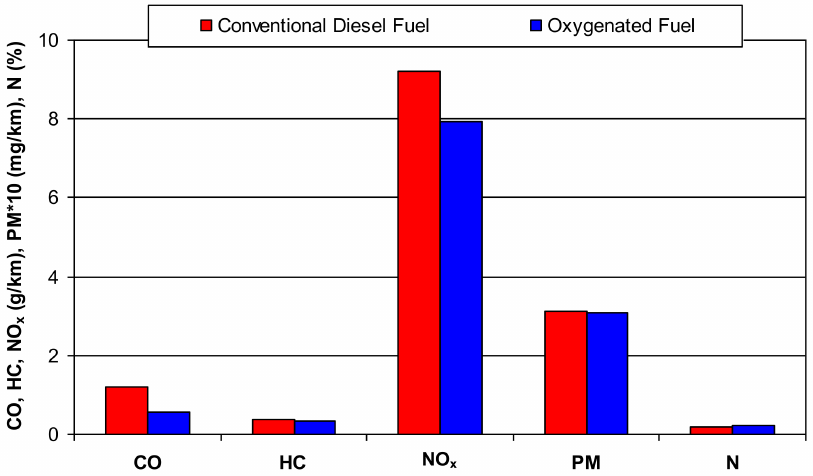
Figure 6. Average road emissions from the Solaris Urbino 18 Hybrid bus fuelled by conventional